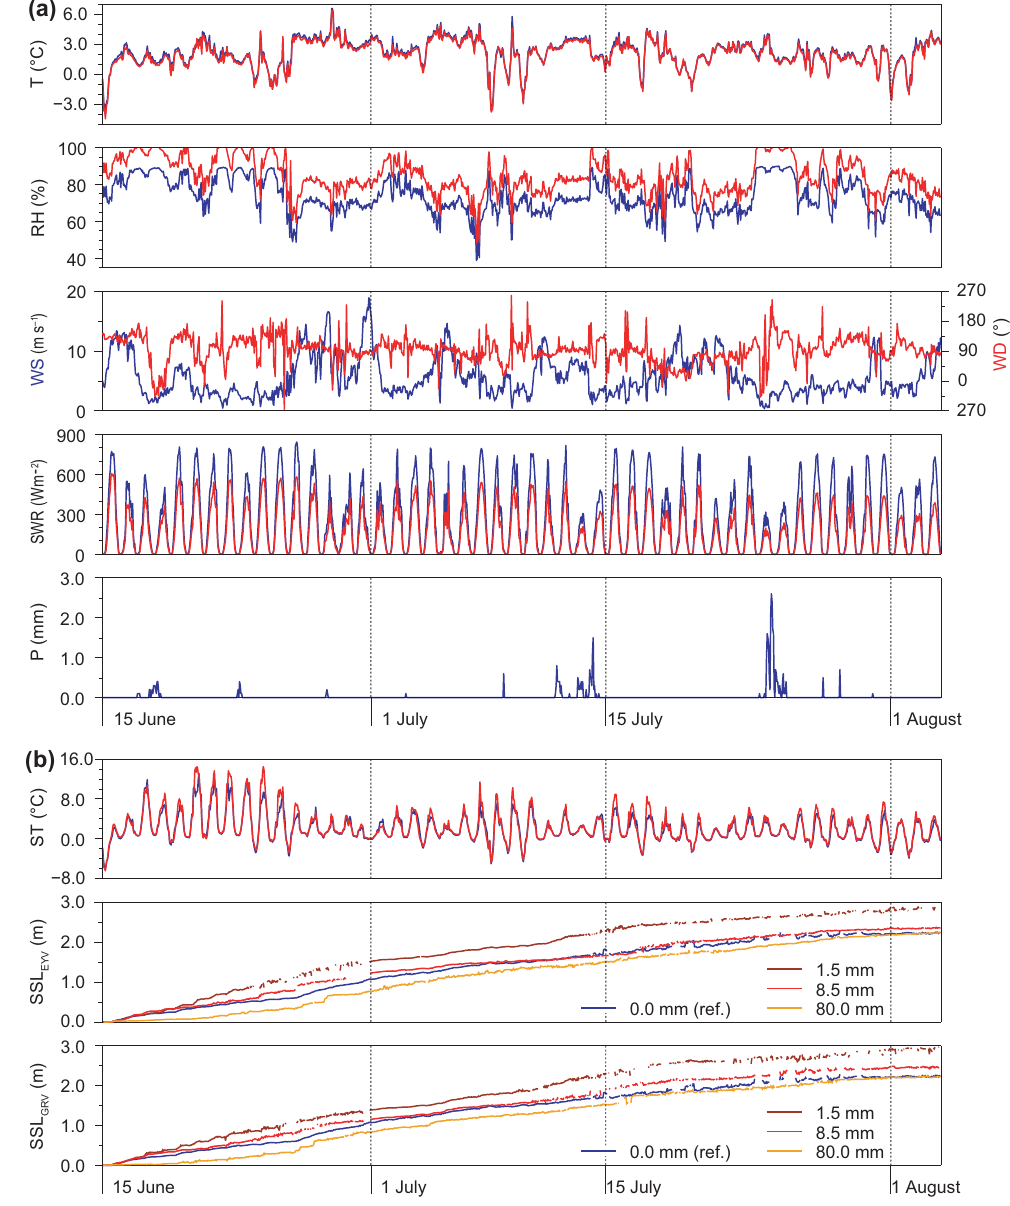
Figure 3. Hourly records of the measurements of all sensors installed at the automatic weather station are shown in (a) , and measurements of all sensors mounted at the field experiment installation are shown in (b) . Records are shown for 15 June to 3 August. For air temperature ( T ) and relative humidity (RH) the records of the upper sensor (blue line) are shown together with those of the lower sensor (red line). Wind speed (blue line) is shown together with wind direction (red line); note the different y axes here. Incoming shortwave radiation (SWR, blue line) is shown together with reflected shortwave radiation (red line). For precipitation ( P ), only the liquid fraction has been measured. Surface temperatures (ST) are shown for the ∼ 80mm plots of tephra from Eyjafjallajökull volcano (EYV, blue line) and from Grímsvötn volcano (GRV, red line). Cumulative snow-surface lowering (SSL) is shown over the different plots (indicated by color codes) of EYV tephra and GRV